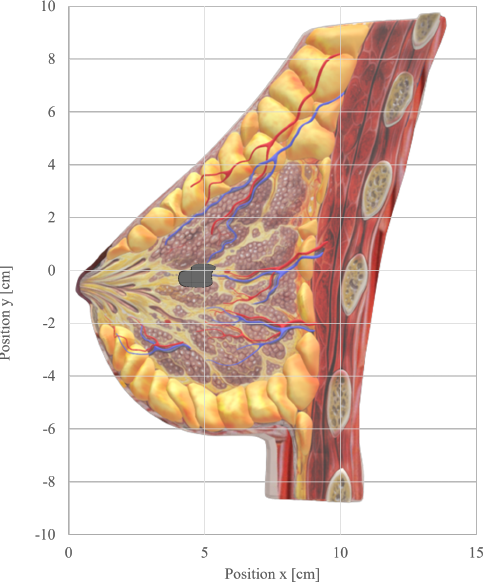
Figure 10. Segmented AustinWoman data with marked target area.